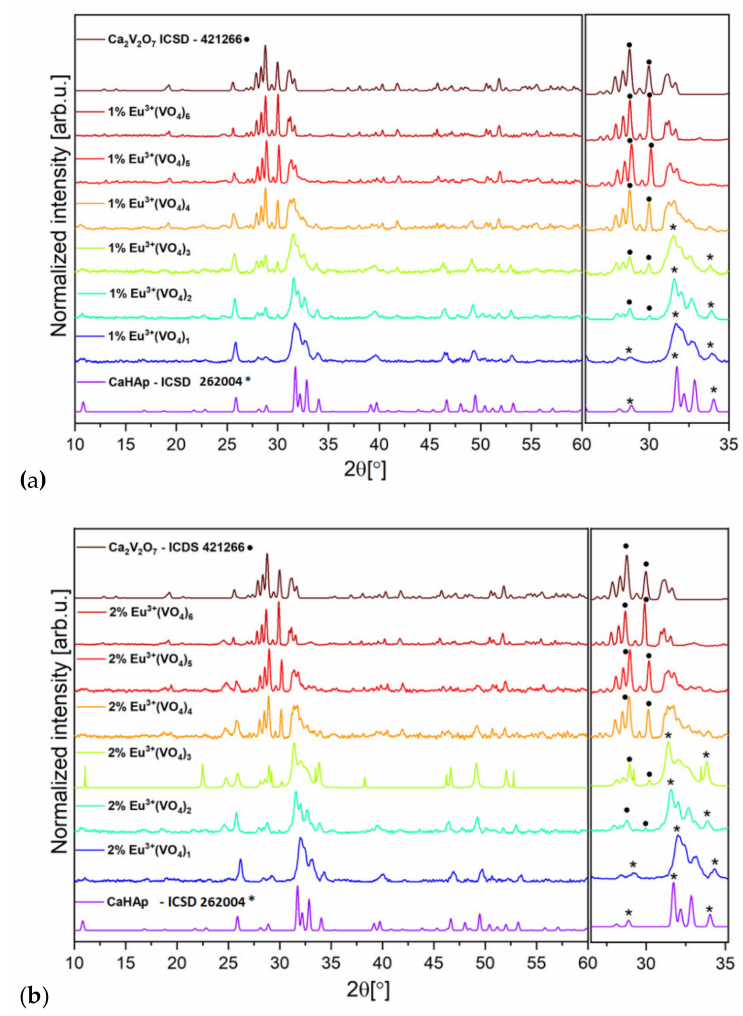
Figure 1. XRD results of ( a ) Ca 9.9 Eu 0.1 (PO 4 ) 6 − x (VO 4 ) x (OH) 2 , and ( b ) Ca 9.8 Eu 0.2 (PO 4 ) 6 − x (VO 4 ) x (OH) 2 , where x is equal 1, 2, 3, 4, 5, and 6. The obtained materials were thermally treated at a temperature of 600 ◦ C for 6 h. The XRD results were compared with the ICSD database hydroxyapatite and calcium pyrovanadate patterns. The signals from hydroxyapatite are labeled with ( * ) and signals from calcium pyrovanadate are labeled with ( •